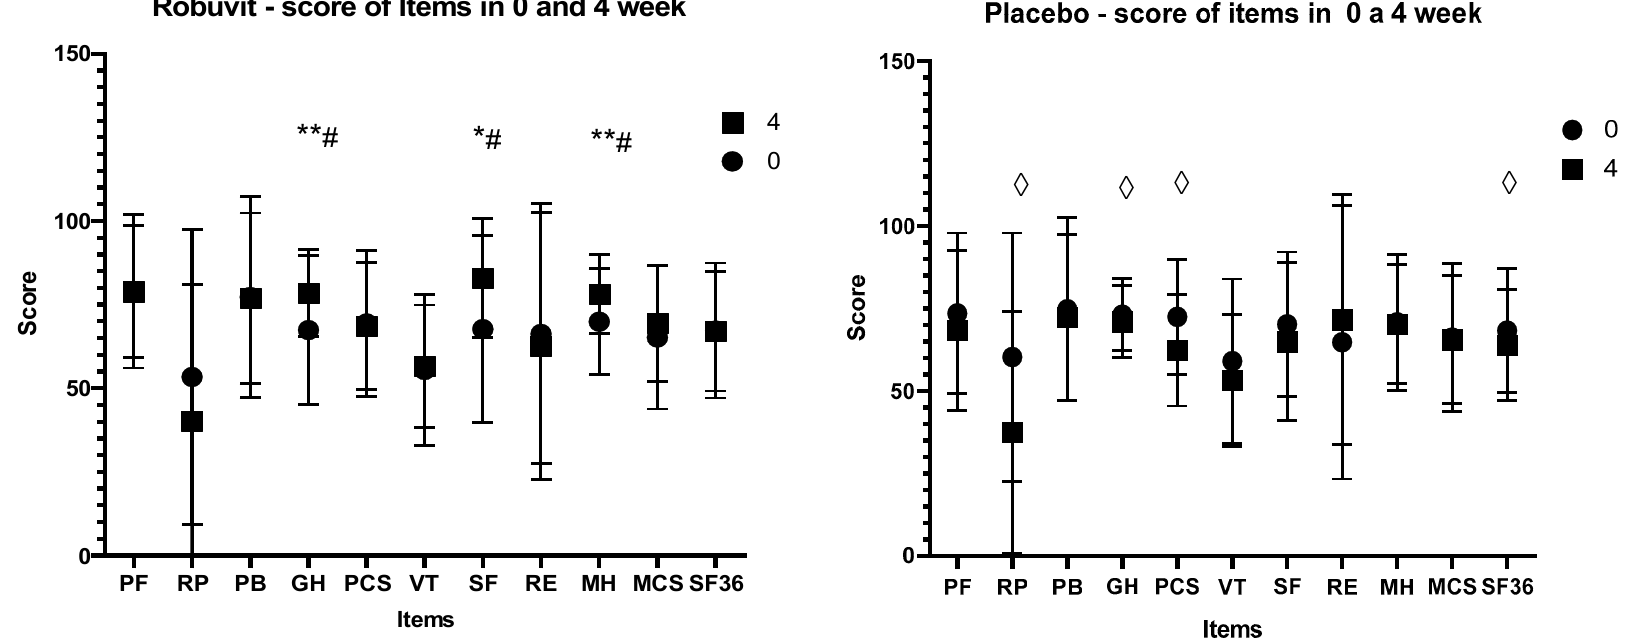
Figure 3. Changes in scores of individual health items after 4–week Robuvit and placebo administration (numbers of analysed data in both groups are given in Flow diagram). R–Robuvit, Pl–placebo, PF–physical functioning, RP–role limitations due to physical health, PB–pain, GH–general health, PCS–physical